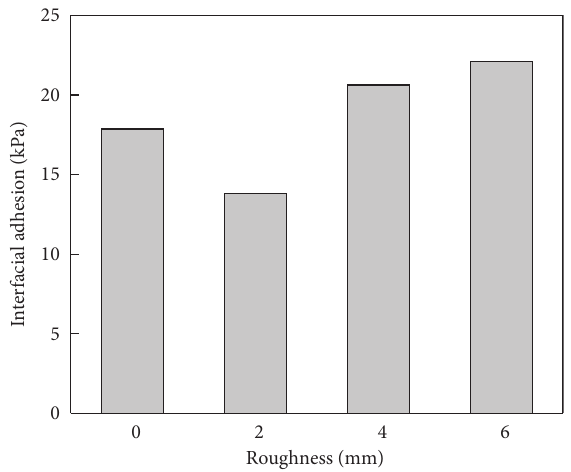
Figure 11: Relationship between interface cohesion and roughness.